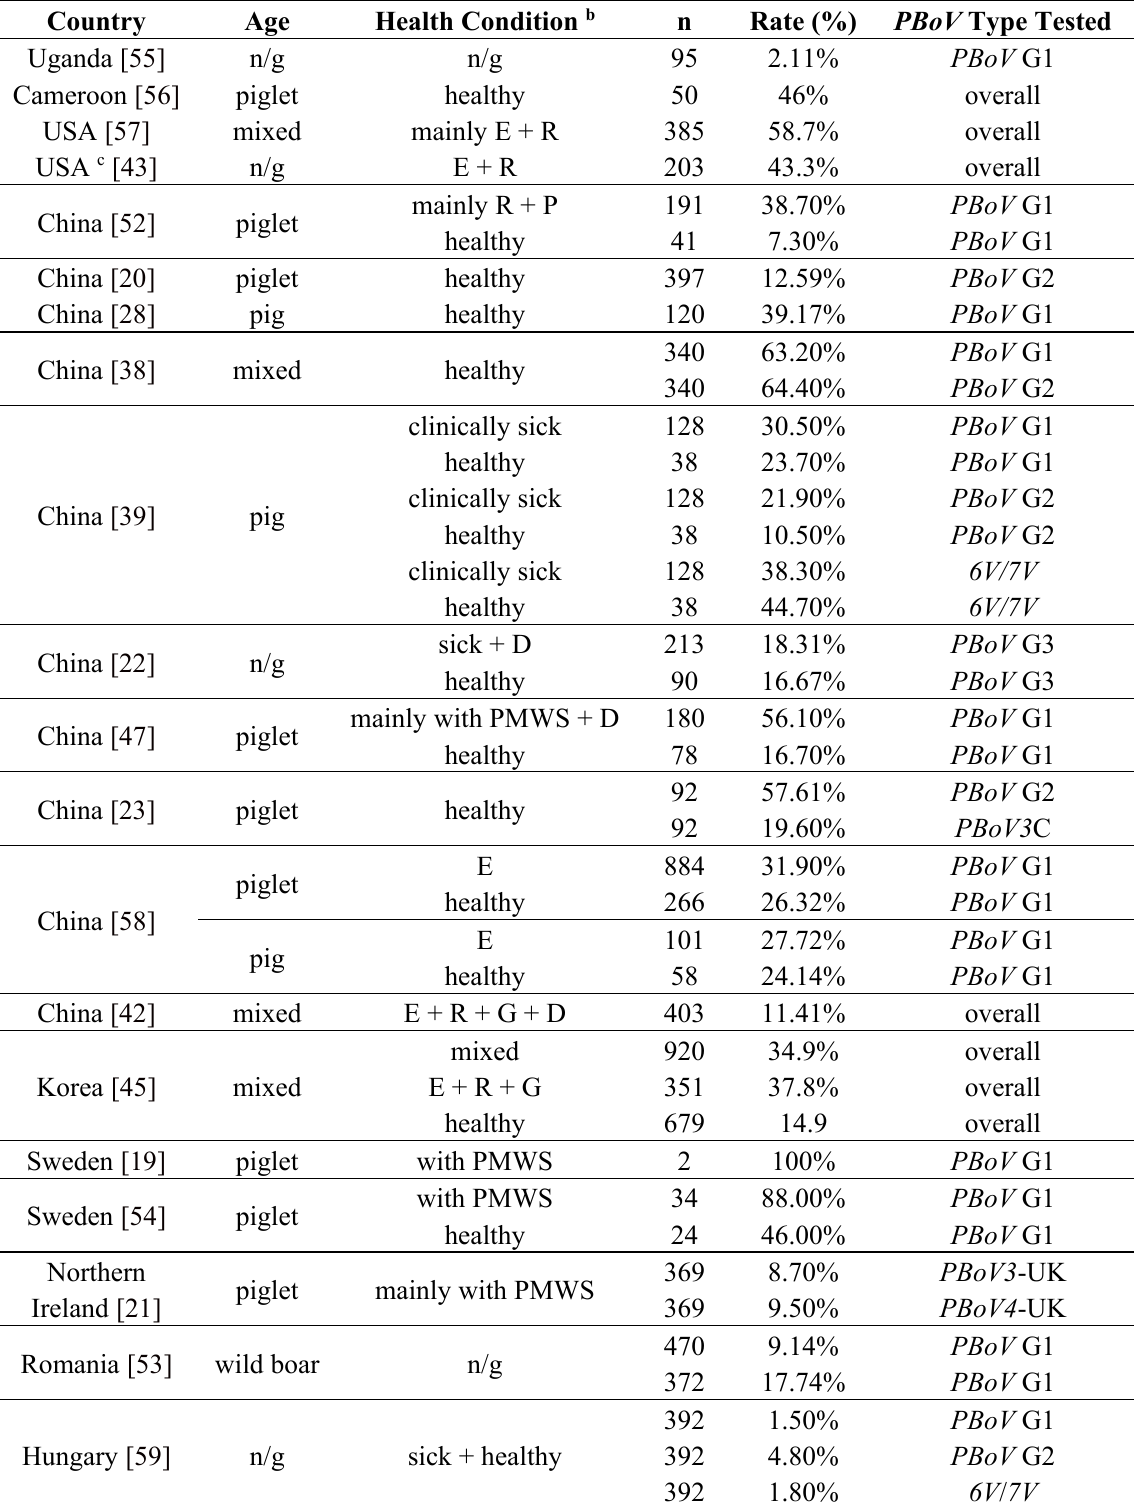
Table 2. Major epidemiological studies of porcine bocaviruses a